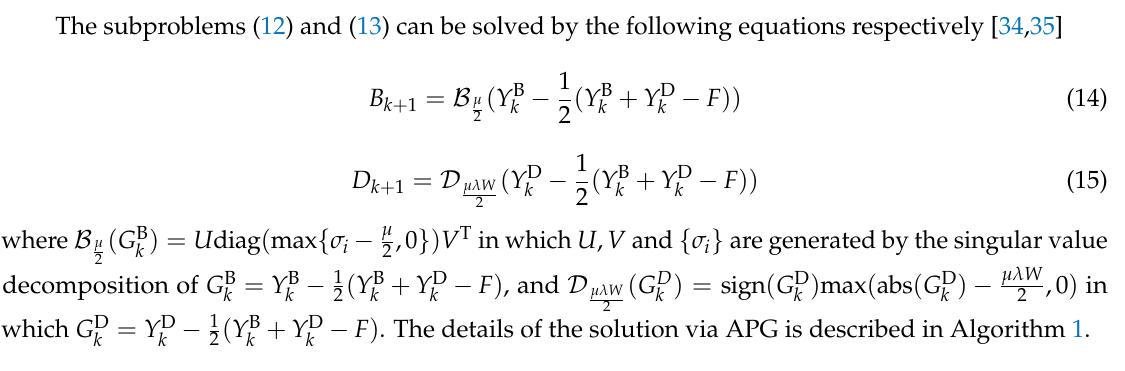
Algorithm 1: Target map extraction by